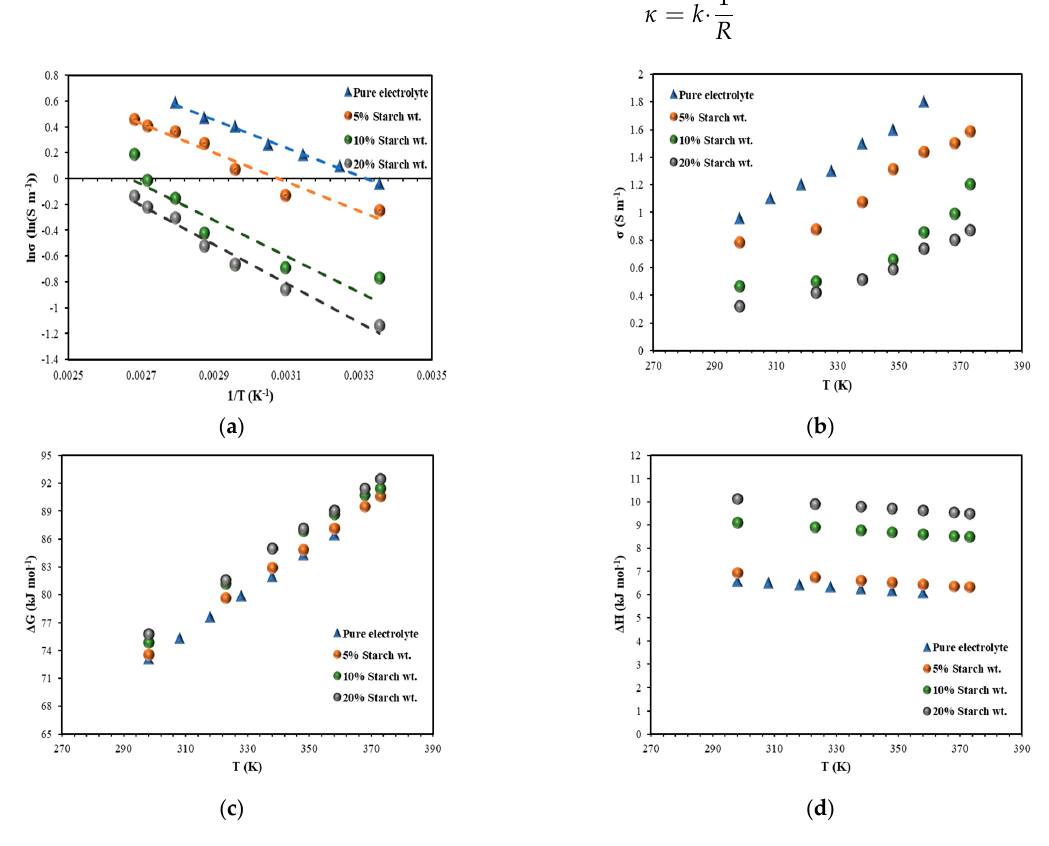
Figure 8. ( a ) Arrhenius equation of 1 M LiPF 6 in EC:DMC (1/1 v / v ) and with CS additive with 5%, 10% and 20% wt. additive; ( b ) dependence of specific conductivity on temperature; ( c ) dependence of Gibbs free energy on temperature; ( d ) dependence of enthalpy on temperature.